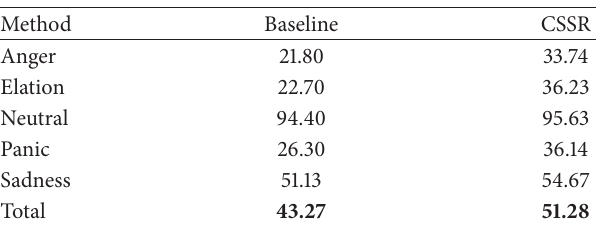
Table 1: Comparison of system performance under different types of affective speech (%).